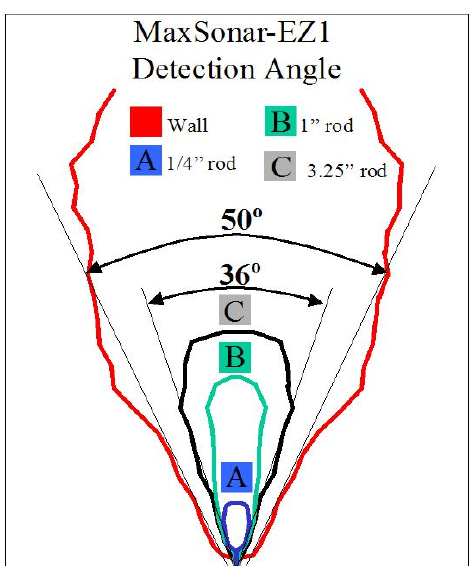
Figure 7: Target detection angle of ultrasonic sensor (Photo credit: